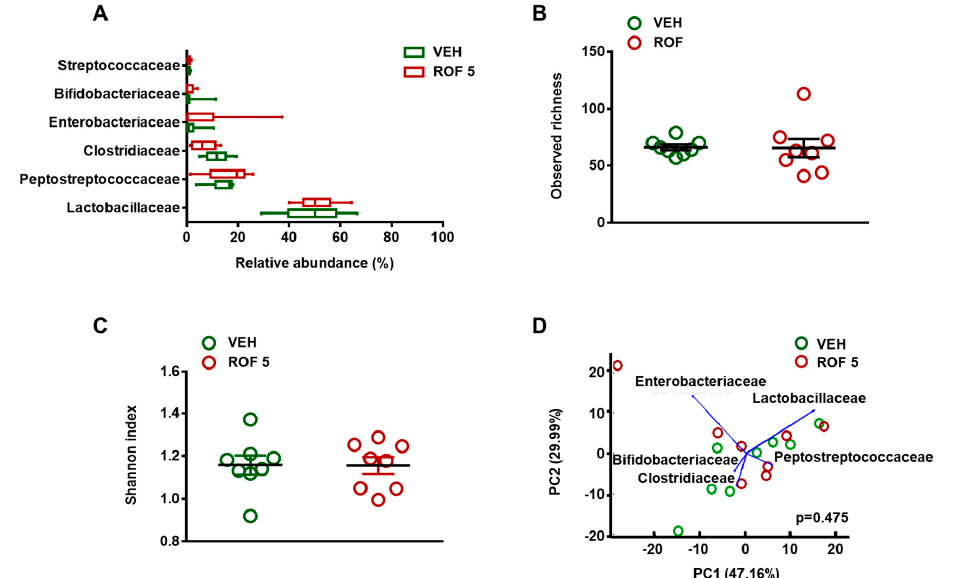
Figure 5. The effects of four-week vehicle (VEH, 1% methylcellulose) and rofecoxib (ROF, 5 mg/kg) treatment on the jejunal microbiota. ( A ): Relative abundances of the most abundant bacterial families in the jejunum. Box and whisker plots indicate the medians, first and third quartiles, and the minimum and maximum values. Panels ( B ) and ( C ): Bacterial richness (observed operational taxonomic units) and diversity estimated by the Shannon index, circles represent the data of each rat, bars indicate the mean ± SEM. ( D ): Principal component analysis (PCA) plot comparing the microbiota composition of vehicle- and rofecoxib-treated rats. The percentage of variation explained by the principal components (PC1 and PC2) is indicated on the axes. There was no clustering between rats treated with vehicle versus rofecoxib. For statistical analysis, Wald test with Benjamini-Hochberg correction ( A ), Mann-Whitney U test ( B , C ), and Hotelling’s T-square test ( D ) were used, n = 8/group.